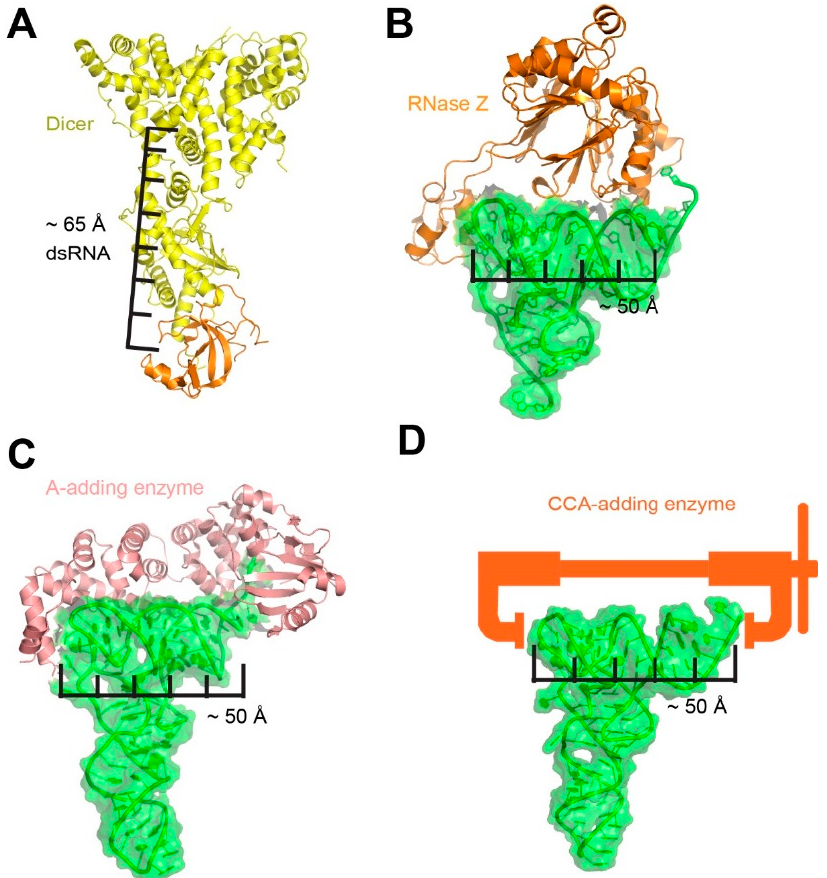
Figure 5. Selected examples of proteins measuring distances on RNA structures. ( A )